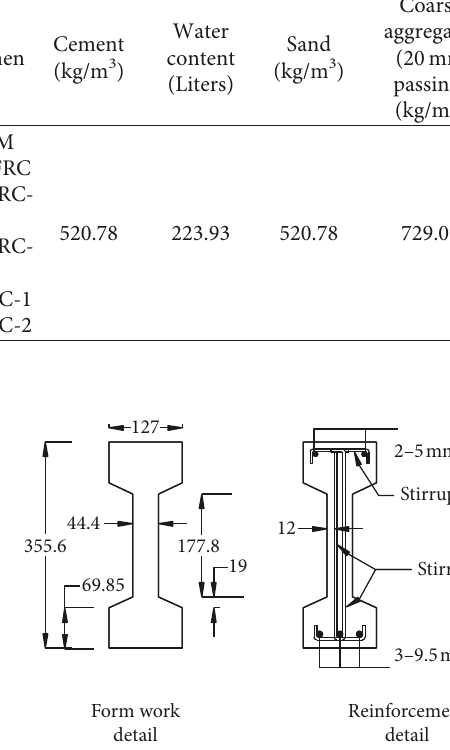
Figure 1: Cross sections showing dimensions and reinforcement details of a typical I-shaped